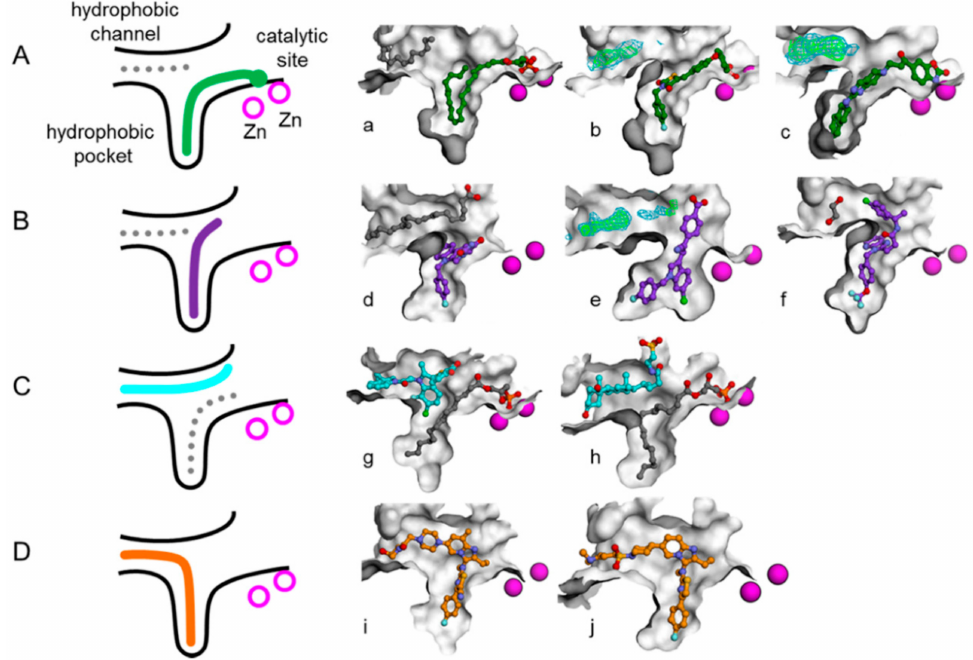
Figure 1. Schematic representation of the autotaxin (ATX) binding pocket and the di ff erent inhibitor binding modes reported to date. (This figure is cited from the reference 22) Type I, II, III, and IV inhibitors are represented in green, purple, cyan, and orange, respectively, on the schema with matching colors for carbon atoms on the exemplified structures. The gray dotted lines represent secondary ligands modeled next to the inhibitor as shown with gray carbons on the illustrations. Zinc ions are depicted in magenta. ( A ) Binding mode of type I inhibitors LPA (lysophosphatidic acid) 22:6 (a), HA-155 (b), and “compound 2”(c). ( B ) Binding mode of type II inhibitors PAT-494 (d), PAT-078 (e), and CRT0273750 (f). ( C ) Binding mode of type III inhibitors PAT-343 (g) and tauroursodeoxycholic acid (h). ( D ) Binding mode of type IV inhibitors GLPG1690 (i) and compound 9